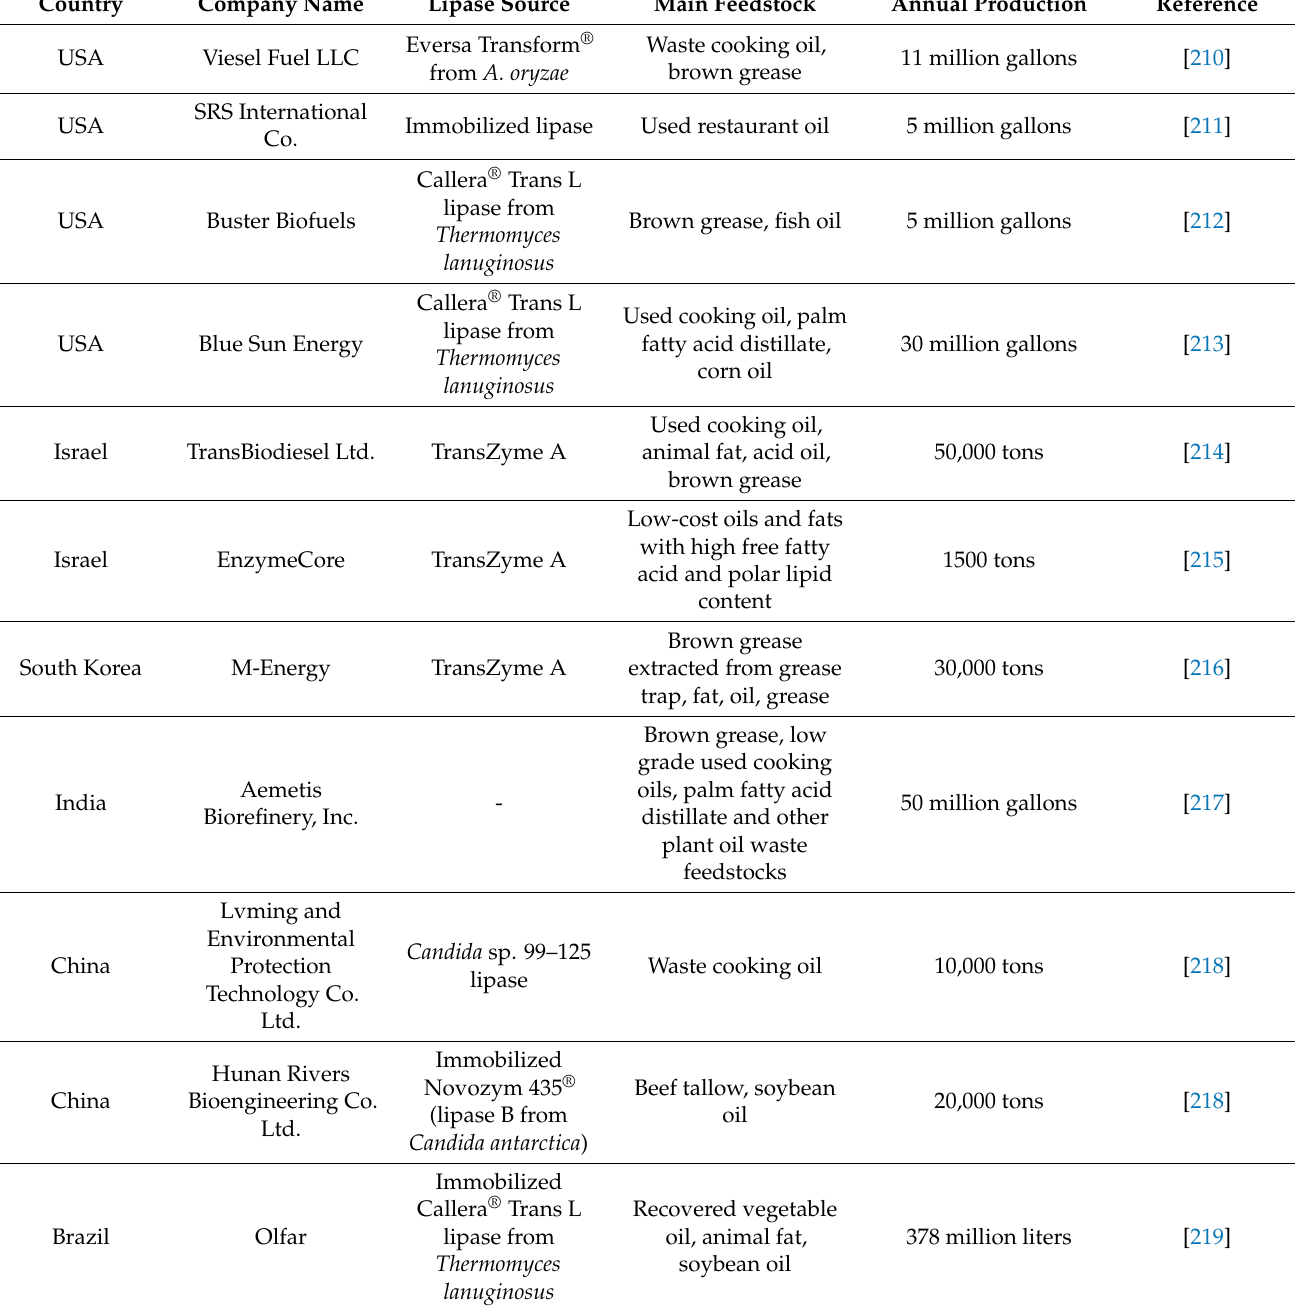
Table 6. Commercial production of enzymatic biodiesel: lipase source, feedstock, and annual production of biodiesel.